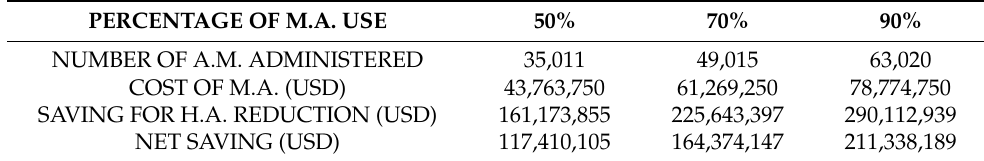
Table 3. Economic implications of extensive monoclonal prescription in patients over the age of 70. PERCENTAGE OF M.A. USE 50% 70% 90% NUMBER OF A.M.